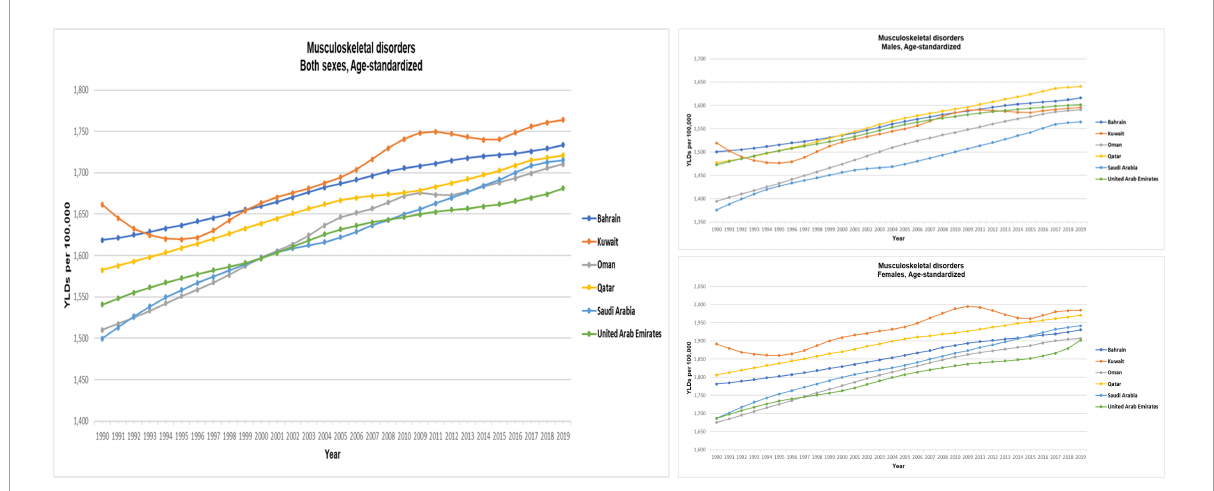
FIGURE2 Age-standardized years lived with disability (rates per 100,000) from MSK disorders for GCC countries, both sexes, Global Burden of Disease 2019 study. The figure is adopted by the Institute for Health Metrics and Evaluation [IHME]